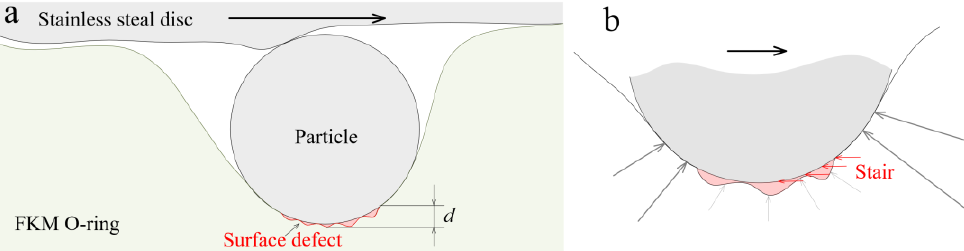
Figure 10. Schematic diagram of ( a ) the three-body contact with the surface defect, and ( b ) the forces on an abrasive particle contact with the surface defect.